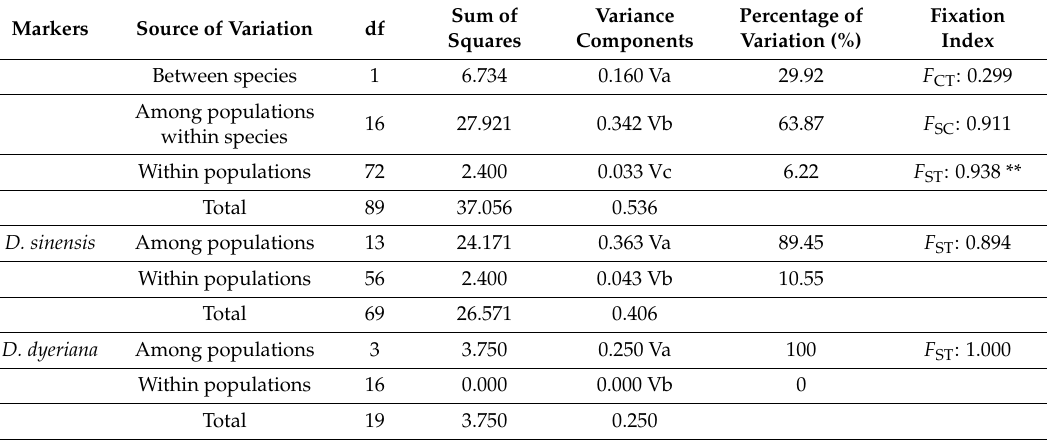
Table 4. Different hierarchical types of analysis of molecular variance (AMOVA) of D. sinensis and D. dyeriana.